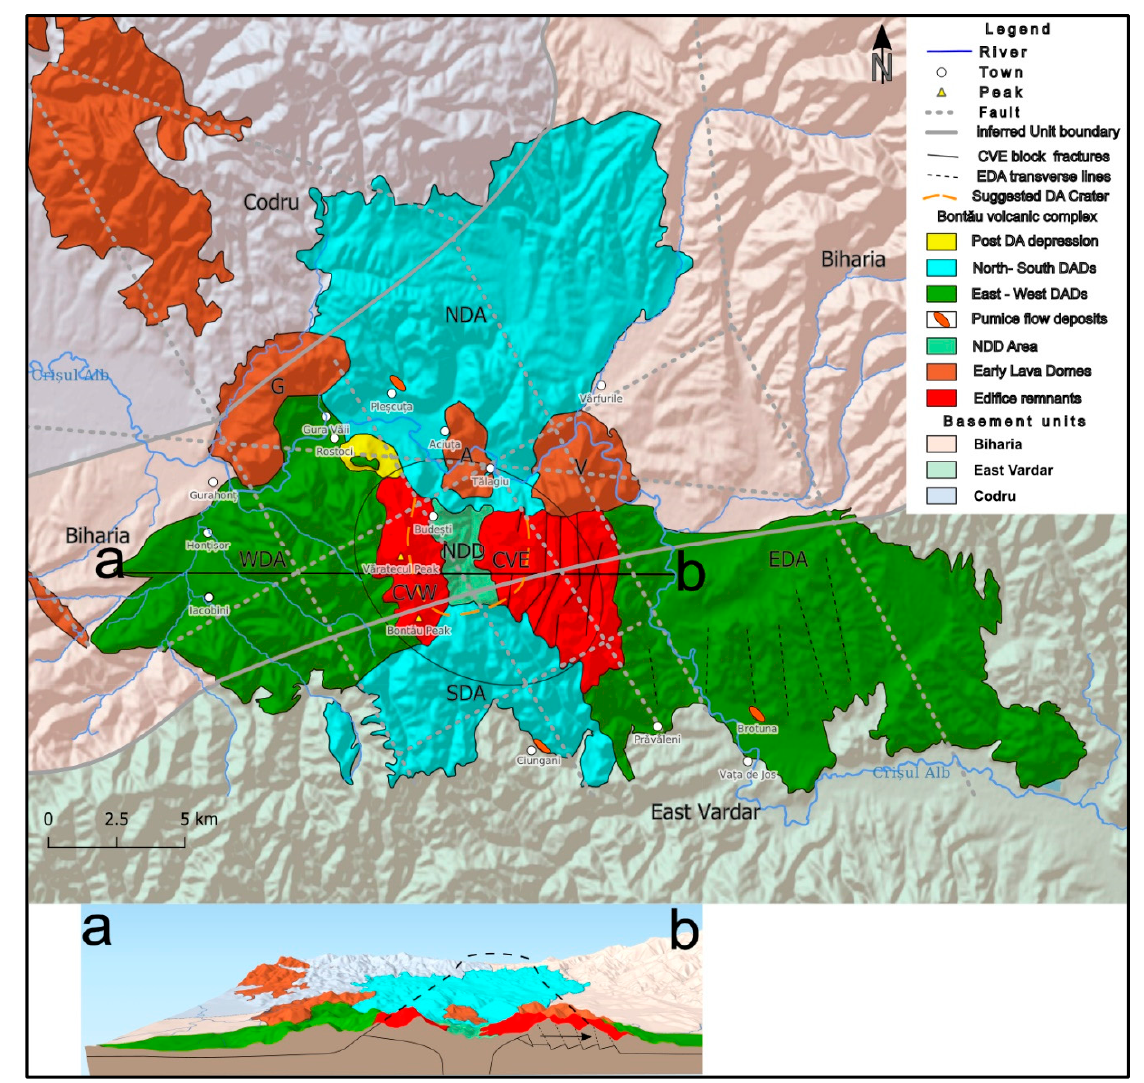
Figure 4. Volcanological features of the Bont ă u volcanic complex without Quaternary deposits. Lava Domes structures: Gurahon ţ (G), Aciu ţ a (A) and a (V); remnants of volcanic edifice: central area of debris-avalanche crater, described as non-differentiated deposits (NDD); western composite volcano edifice remnant (CVW); eastern composite volcano edifice remnant (CVE); NDA, SDA, WDA, EDA: northern, southern, western and eastern debris avalanche units. The oval shape suggests the assumed initial edifice base of the volcano. The 3D profile below ( a - b ), as shown on the map, is suggesting with a dashed line the possible initial shape of the volcano.